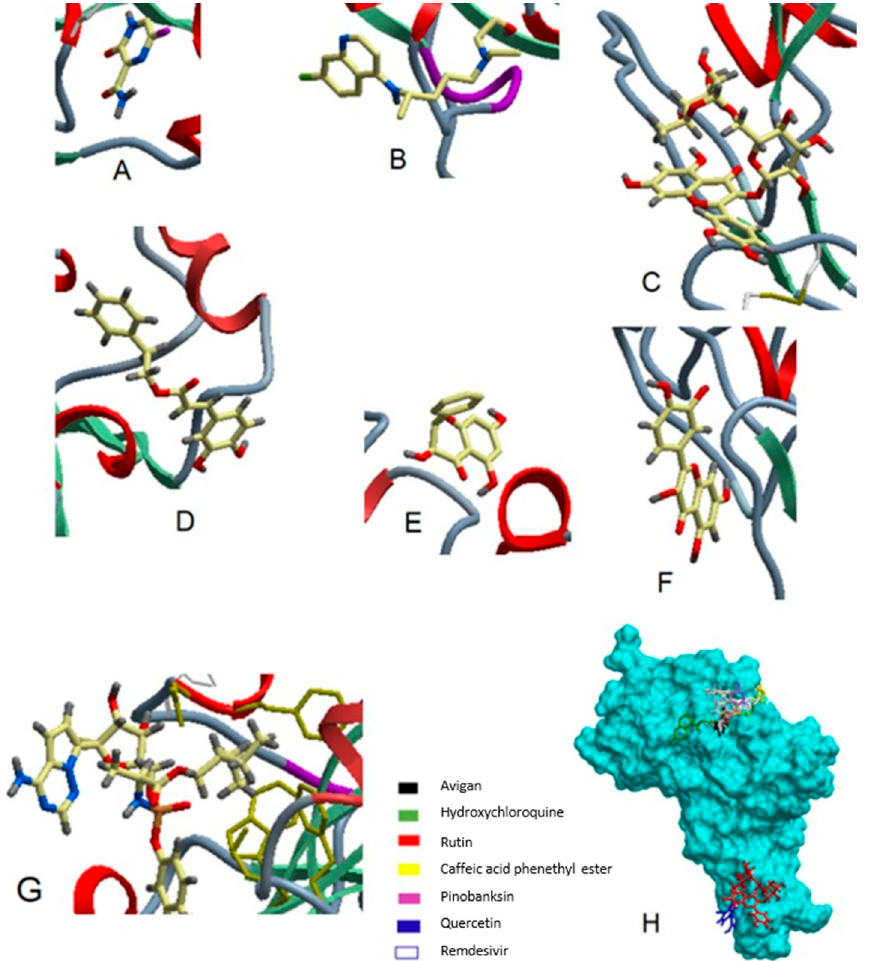
Figure 5. Binding pose ( a ) along with 2D ( b ) and 3D ( c ) analysis of molecular interaction of nar- ingin within the active site of S protein. Reproduced with permission from Jain et al. [78] , Saudi Journal of Biological Sciences, Elsevier, 2021, https://creativecommons.org/licenses/by-nc-nd/4.0/.